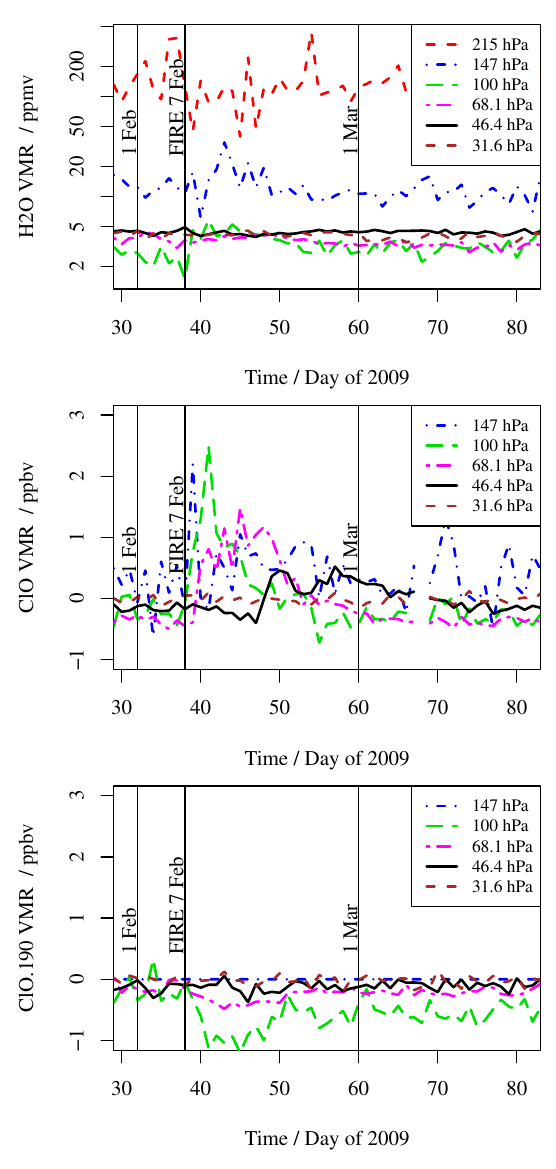
Fig. 6. Time series of the mixing ratio of MLS H 2 O and ClO within the polluted airmass. Note the logarithmic axis used for H 2